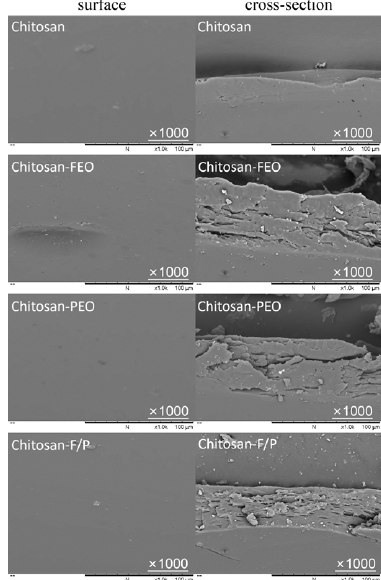
Figure 3. ESEM images of Chitosan, Chitosan-FEO, Chitosan-PEO, and Chitosan-F/P